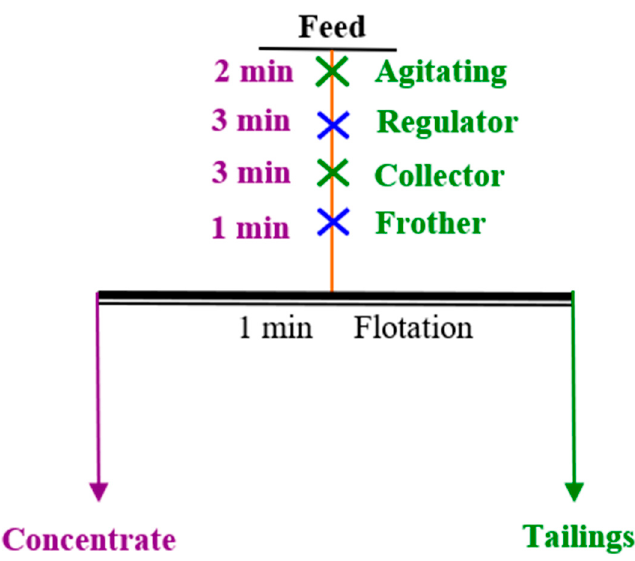
Figure 4. Flotation experiments process.